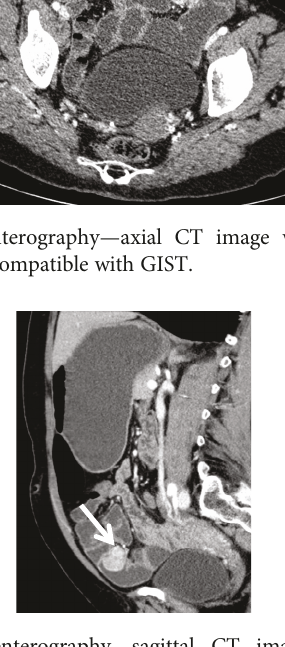
Figure 5: CT enterography — sagittal CT image with lesion compatible with GIST.